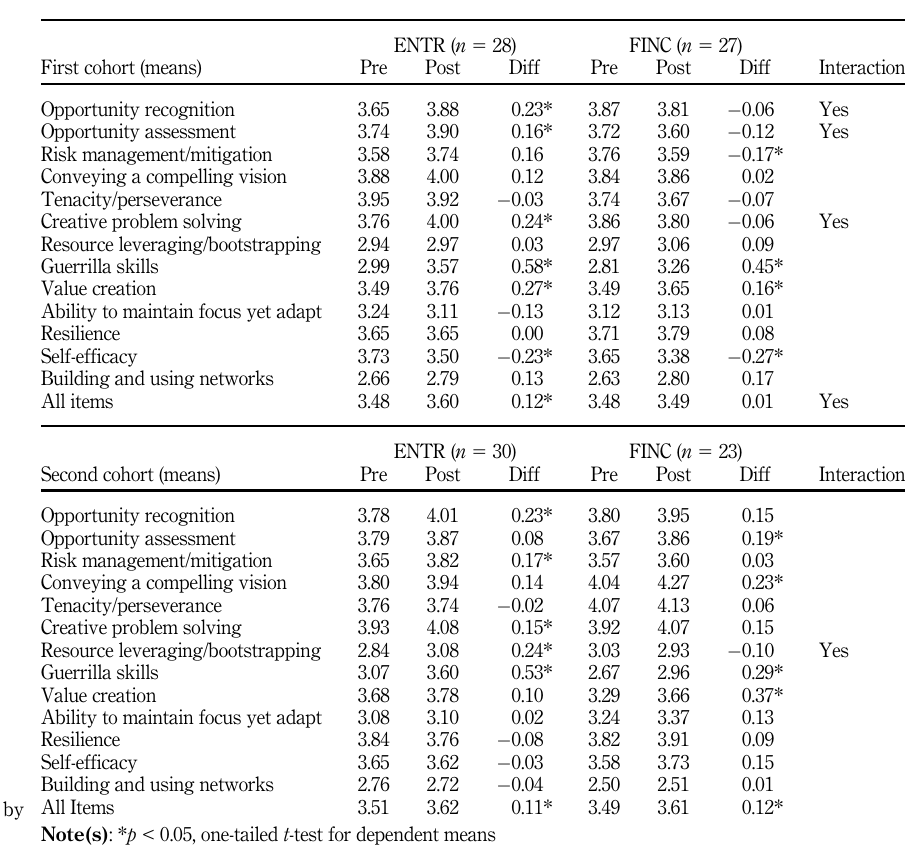
Table 6. Mean competencies by cohort and